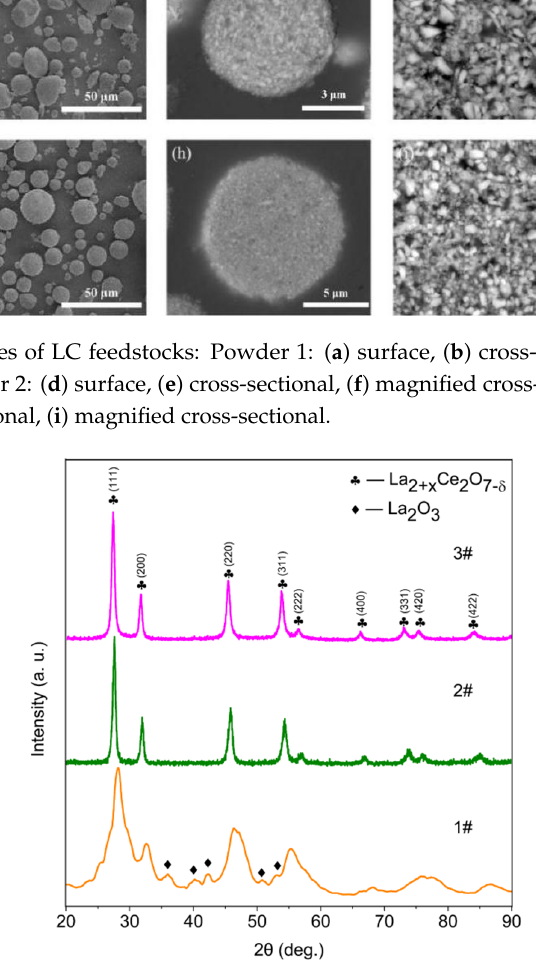
Figure 2. XRD patterns of LC feedstocks.